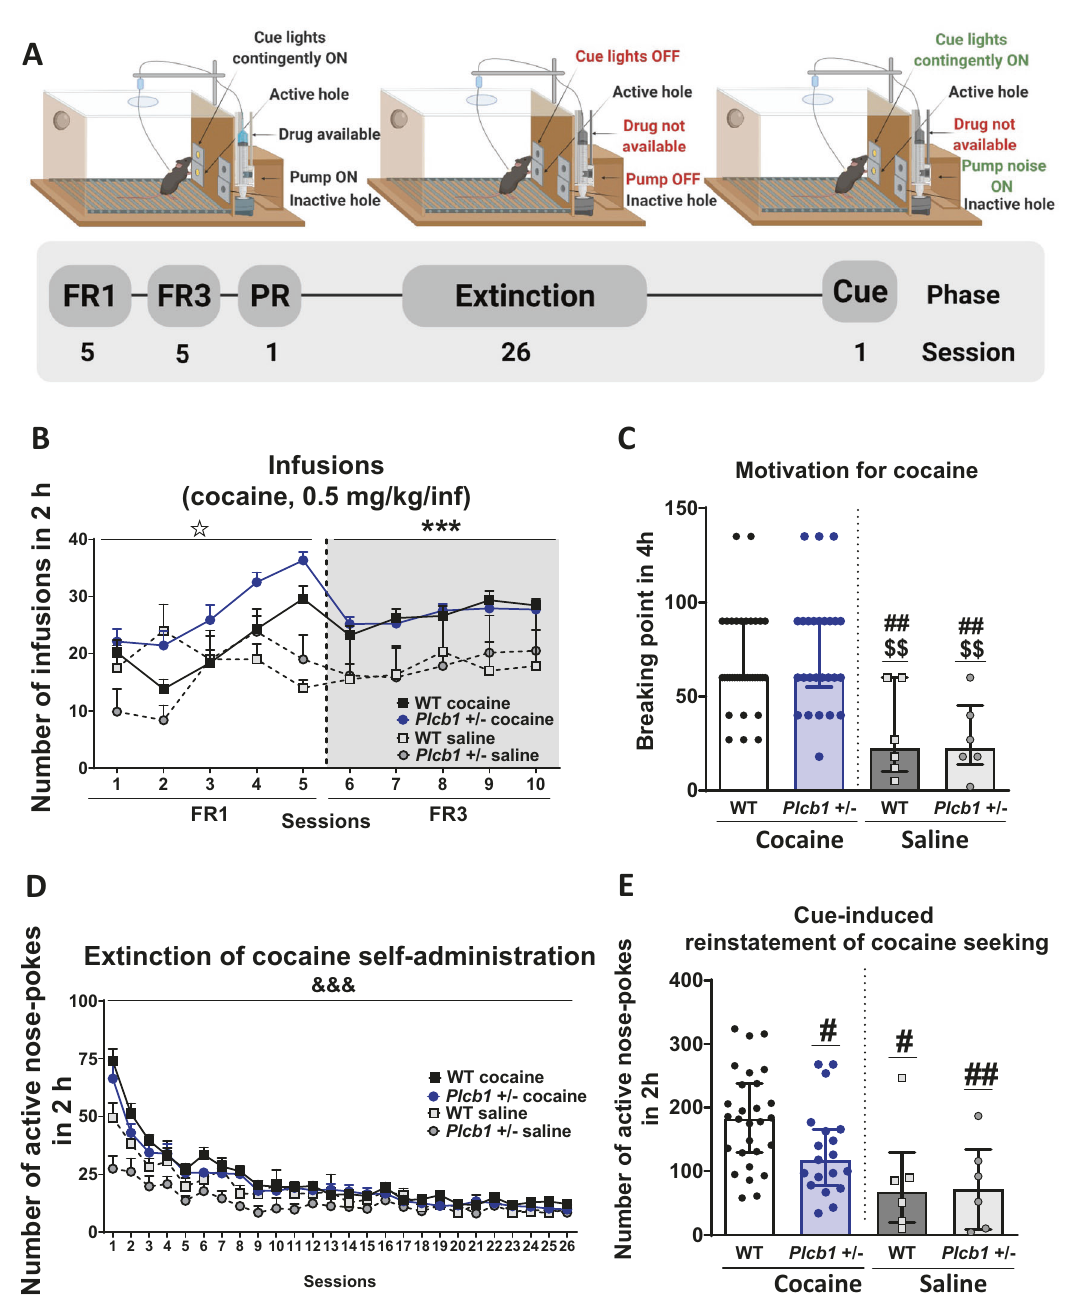
Fig. 2 Operant conditioning maintained by cocaine in Plcb1 + / − , wild-type (WT) and corresponding control saline mice. A Timeline of the experimental sequence. B The number of cocaine infusions (0.5 mg/kg/infusion) in both genotypes increased progressively across sessions during FR1 (repeated measures ANOVA, interaction between genotype × drug × sessions, ✩ P < 0.05) and remained stable during FR3 and higher in mice trained with cocaine (repeated measures ANOVA, main effect of drug, *** P < 0.001). The maximum number of infusions was reached on session 5 in both genotypes and was slightly superior in Plcb1 + / − (36.35 ± 1.47) than in WT (29.61 ± 2.23) but post-hoc analyses demonstrated that this differ- ence was not signi fi cant. C The motivation for cocaine was equivalent in both genotypes trained with cocaine but higher than